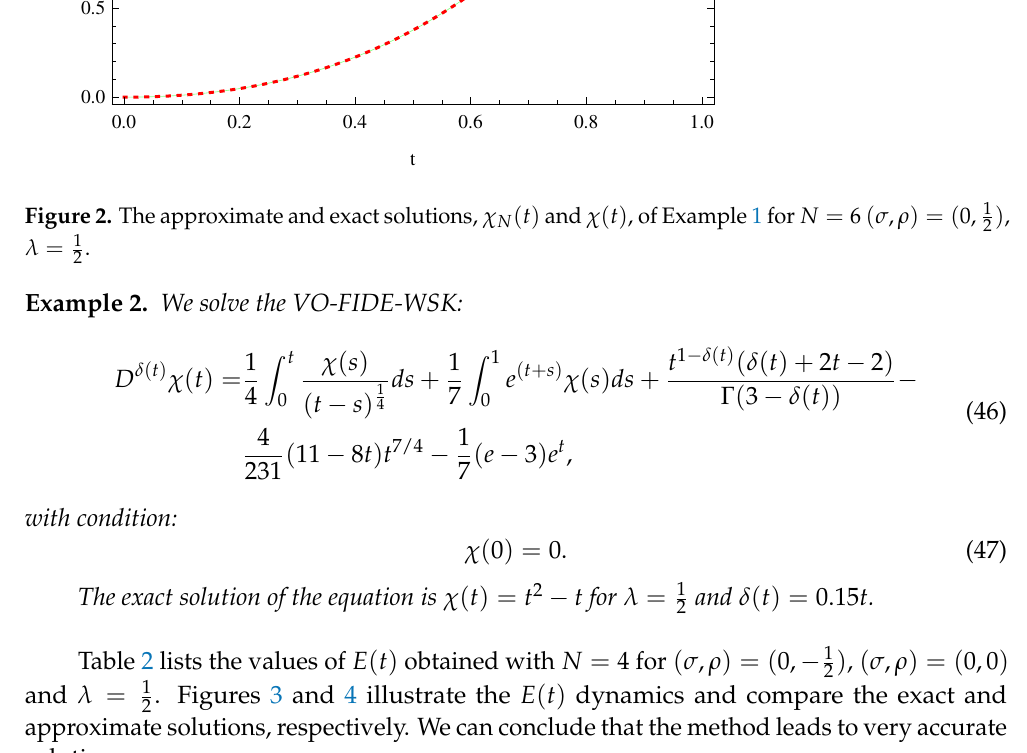
Table 2. The E ( t ) of Example 2 obtained with N = 4 for ( σ , ρ ) = ( 0, − 1